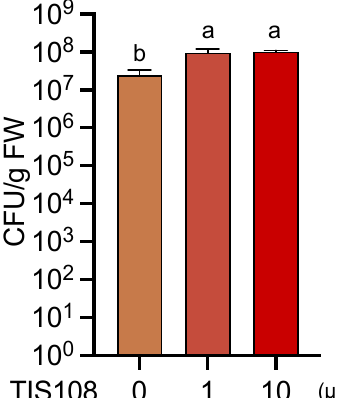
Figure 8. Effects of strigolactone biosynthesis inhibitor TIS108 on Pst growth in Arabidopsis leaf tissues. Three-week-old plants were treated with 0.02% dimethyl sulfoxide (DMSO) (control) or 1 or 10 µM TIS108 by drenching the soil 3 d before inoculation with Pst (2 × 10 5 CFU/mL). Leaves were homogenized 3 d post-inoculation, and the number of CFUs was estimated using their growth on nutrient broth agar plates. Values are means ± SE of six replicates, each with three leaves. Different letters indicate significant differences (Tukey’s multiple comparison test, p < 0.05).